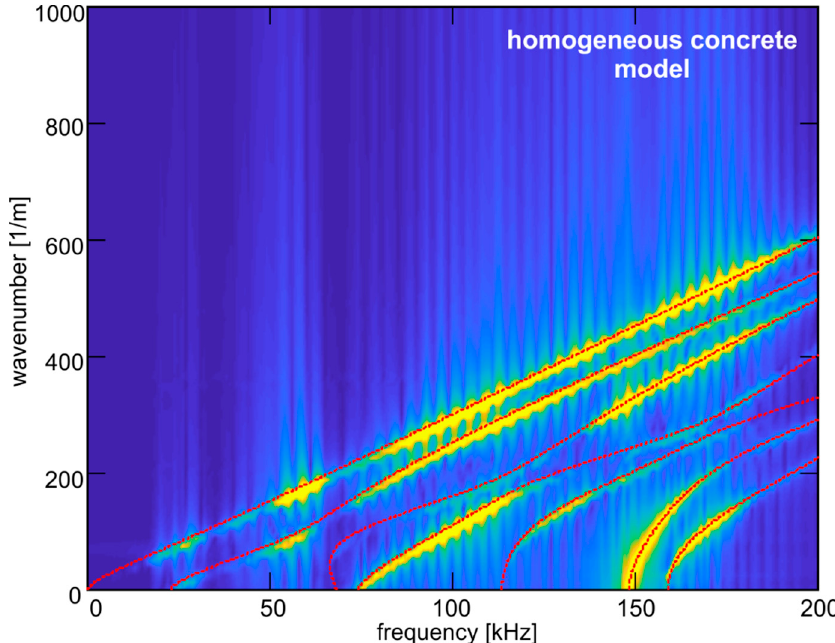
Figure 9. Wavenumber–frequency representation for homogeneous concrete model. Materials 2020 , 13 , 2570